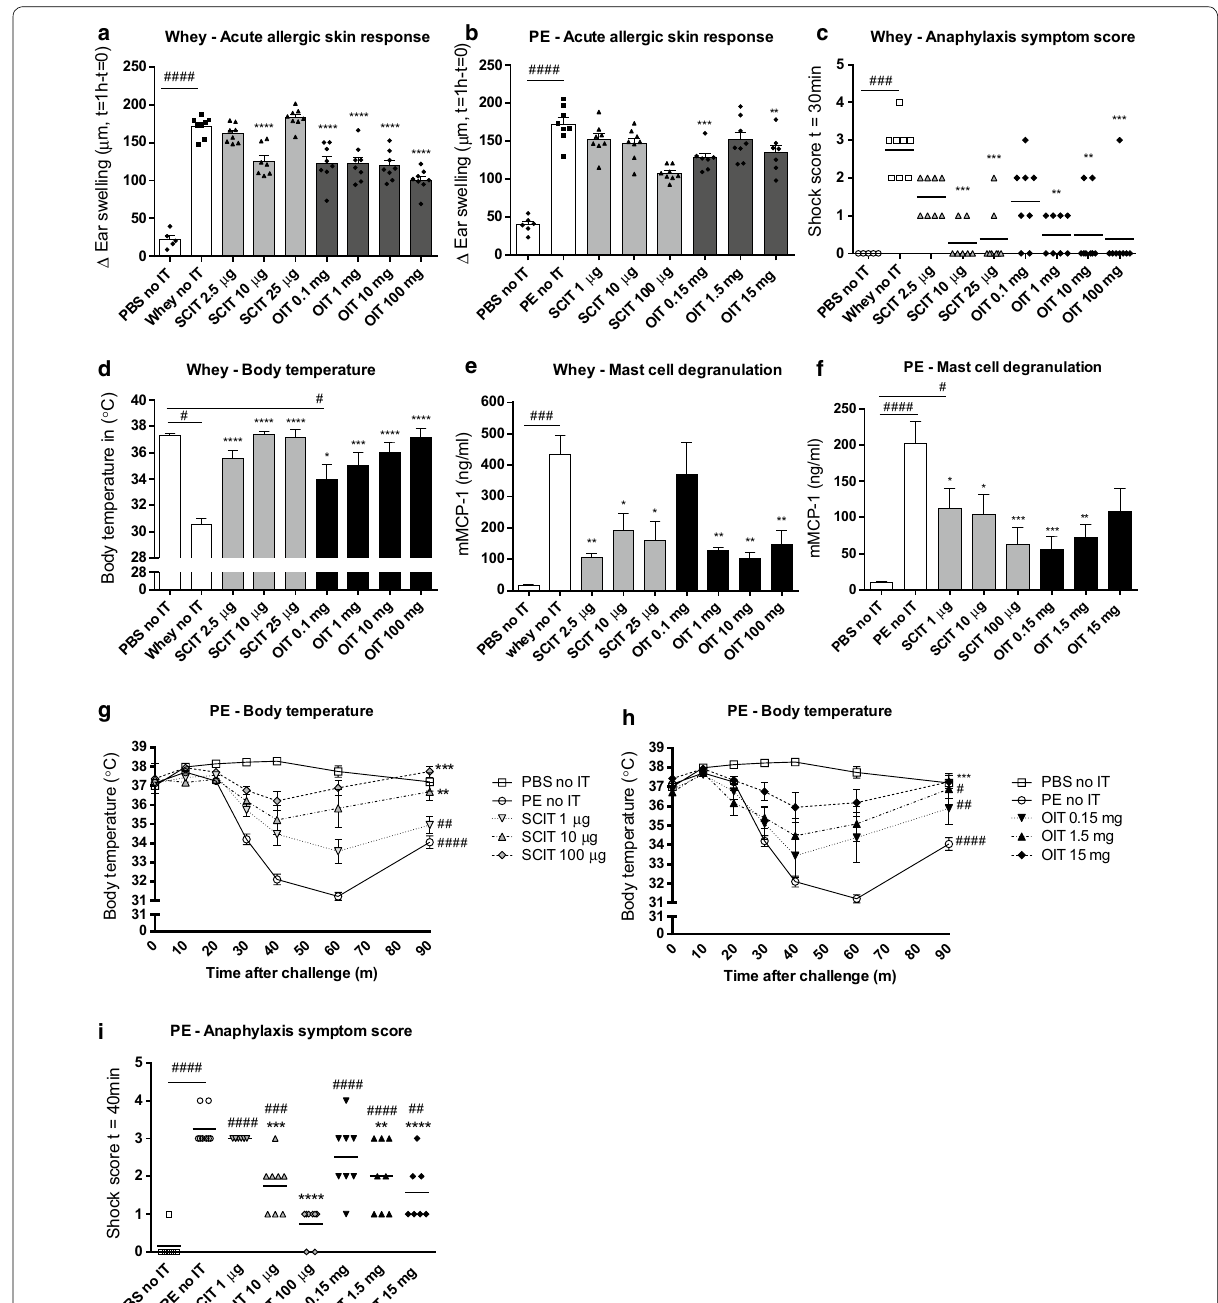
Fig. 2 Allergic manifestations evaluated in whey- or PE-sensitized mice after receiving SCIT and OIT. a , b Acute allergic skin response measured as Δ ear swelling 1 h after i.d. challenge. c Anaphylactic shock symptom scores determined 30 min after i.d. challenge in CMA model. d Body tempera- ture measured 30 min after i.d. challenge in CMA model. e , f Concentrations of mMCP-1 in serum collected 30 min after i.g. challenge. g , h Change in body temperature after i.p. challenge in PNA model. i Anaphylactic shock symptom scores determined 40 min after i.p. challenge in PNA